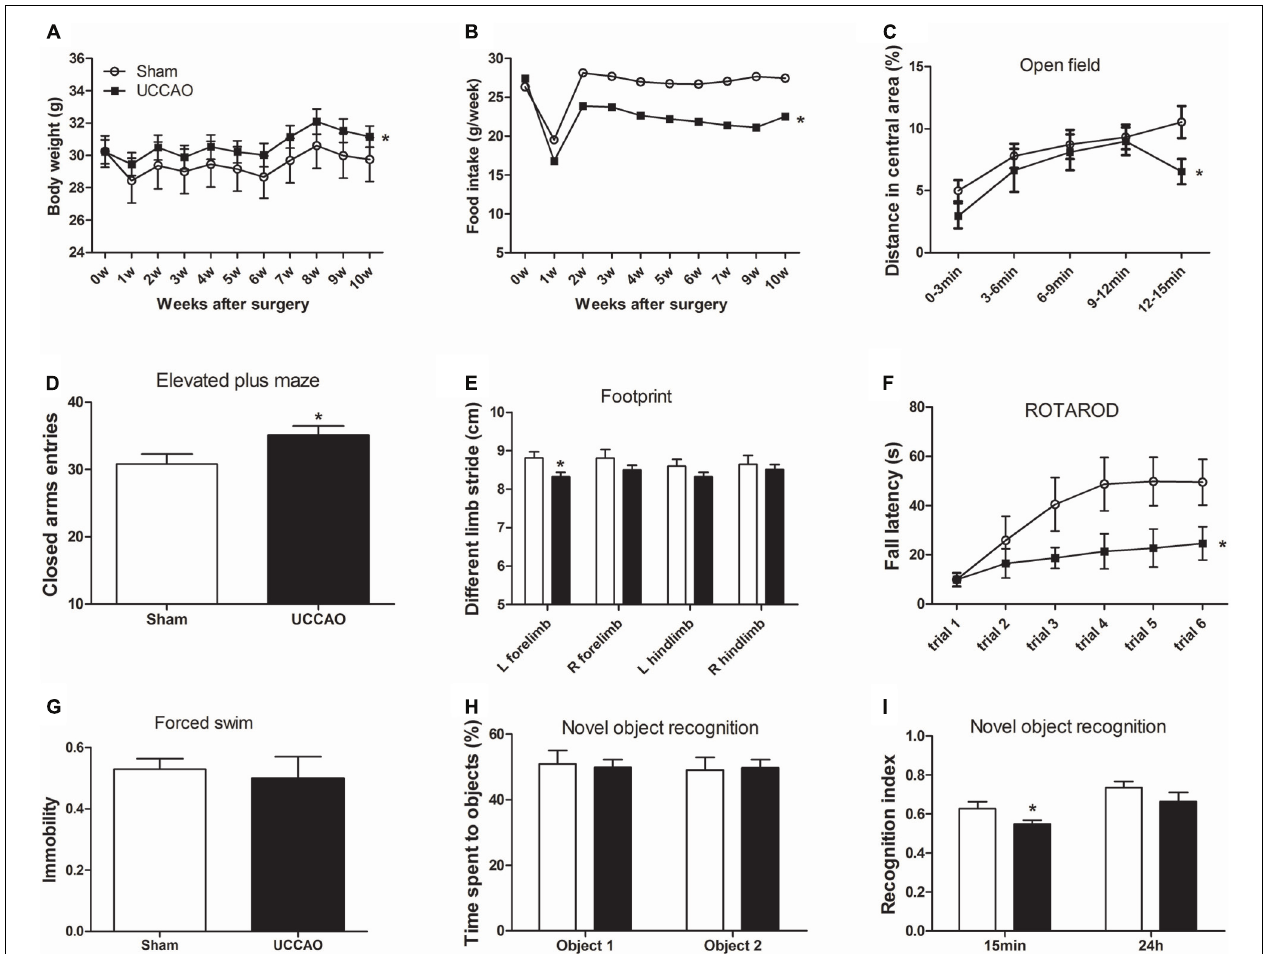
FIGURE 2 | General behavior and short-term memory of mice with CCH. The body weight and food intake were monitored once a week after sham or UCCAO surgery (A,B) . Spontaneous locomotor and exploratory activity was assessed in an open field (C) . Anxiety-like behaviors were evaluated in an elevated plus maze, and the CAs entries are shown (D) . Gait was evaluated using footprint test, and different limb strides are shown (E) . Motor coordination and balance were evaluated using accelerating Rotarod, and the